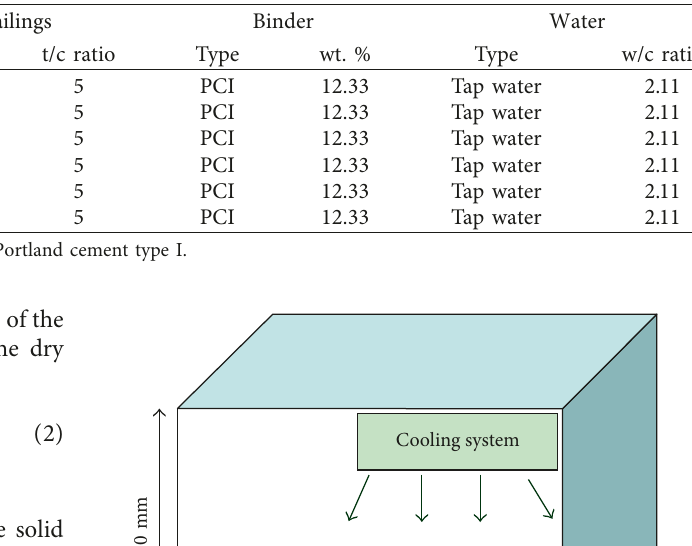
Table 2: Composition of different paste samples used in this study.